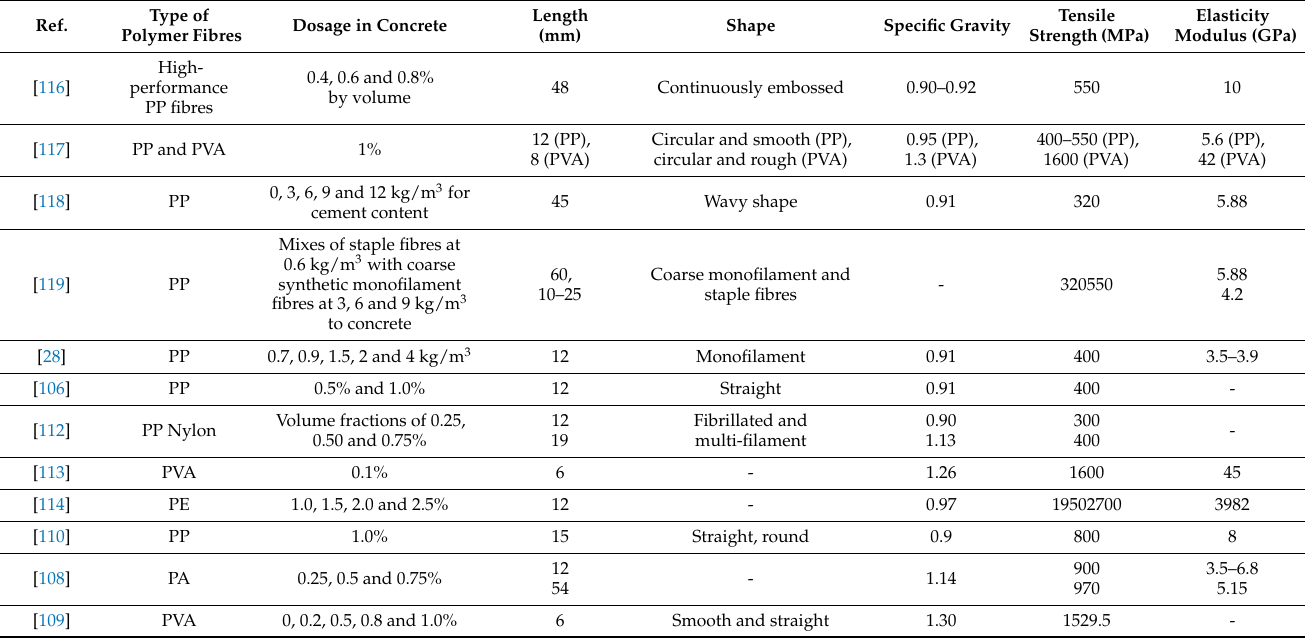
Table 5. Mechanical properties of cementitious materials containing